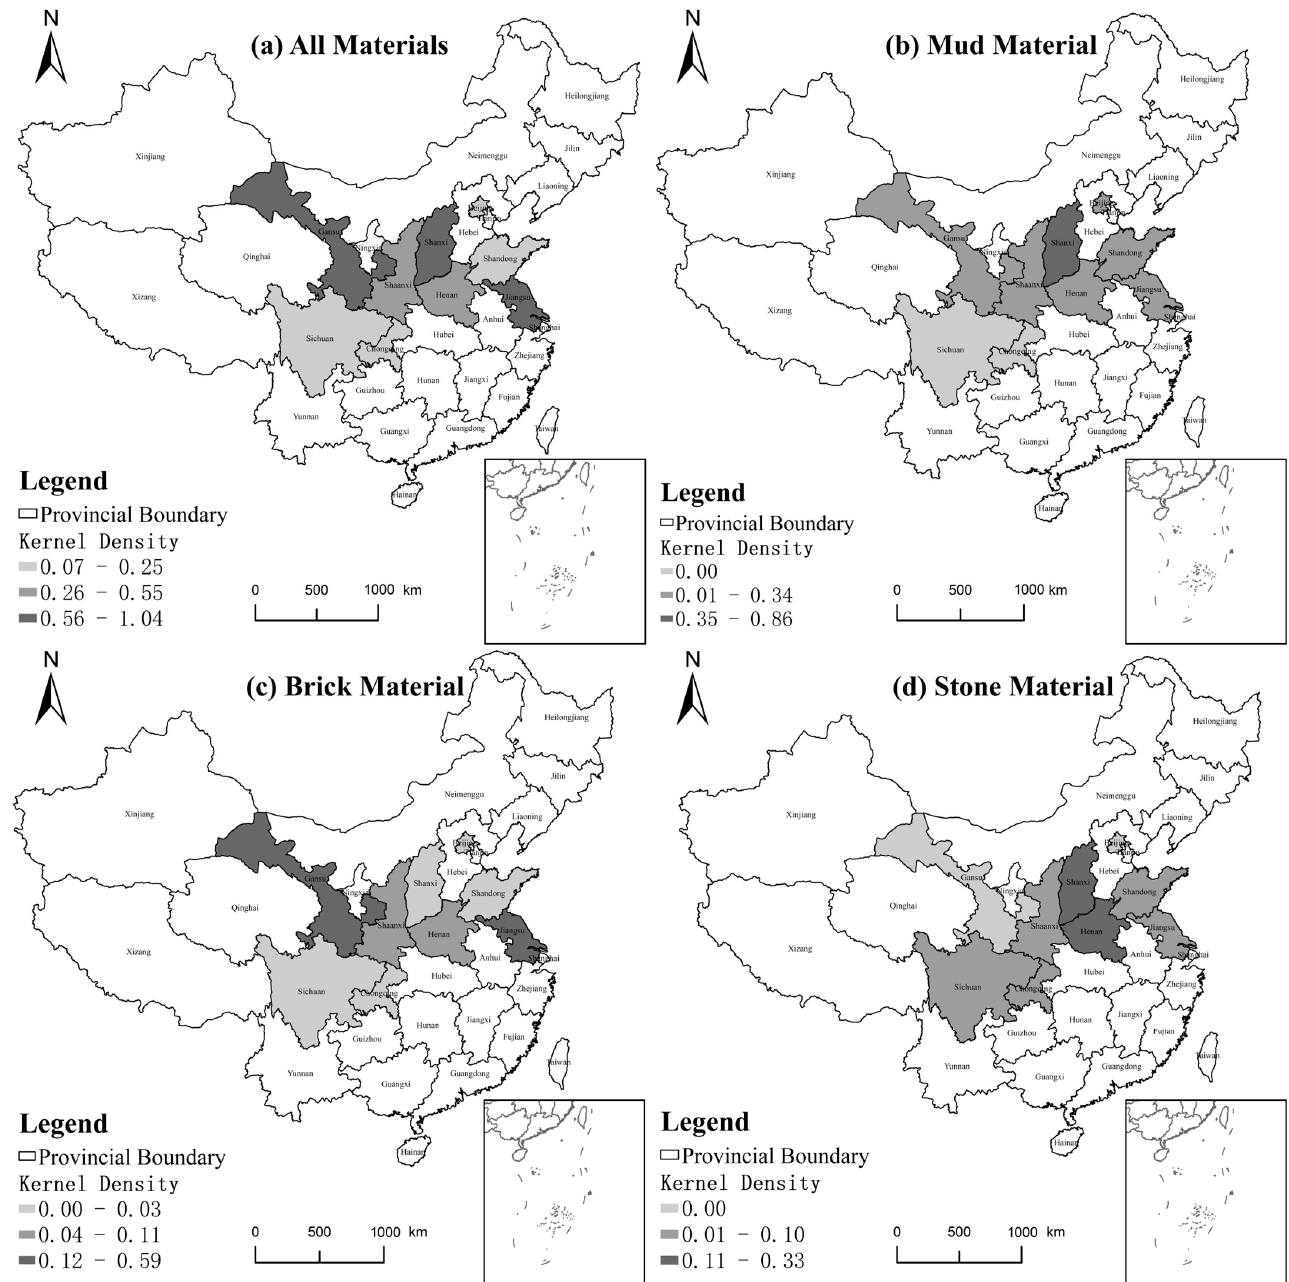
Figure 6. Distribution map of the kernel density of types of relics sites in the Wei, Jin, Southern, and Northern Dynasties. Northern